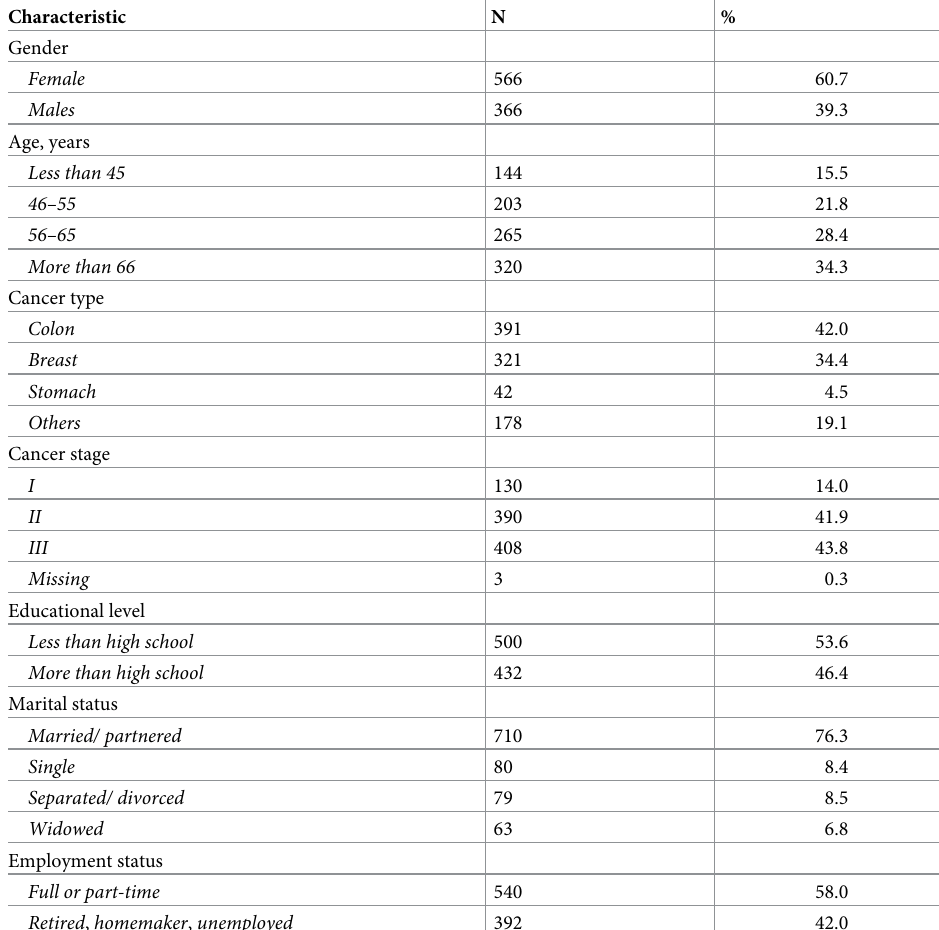
Table 1. Patient characteristics (n =